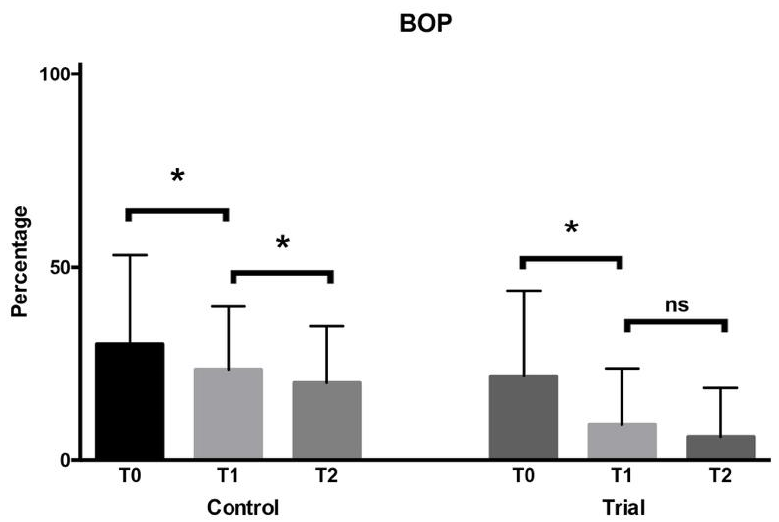
Figure 4. BoP values among the time frames of the study. * = p < 0.05. ns = not significant.